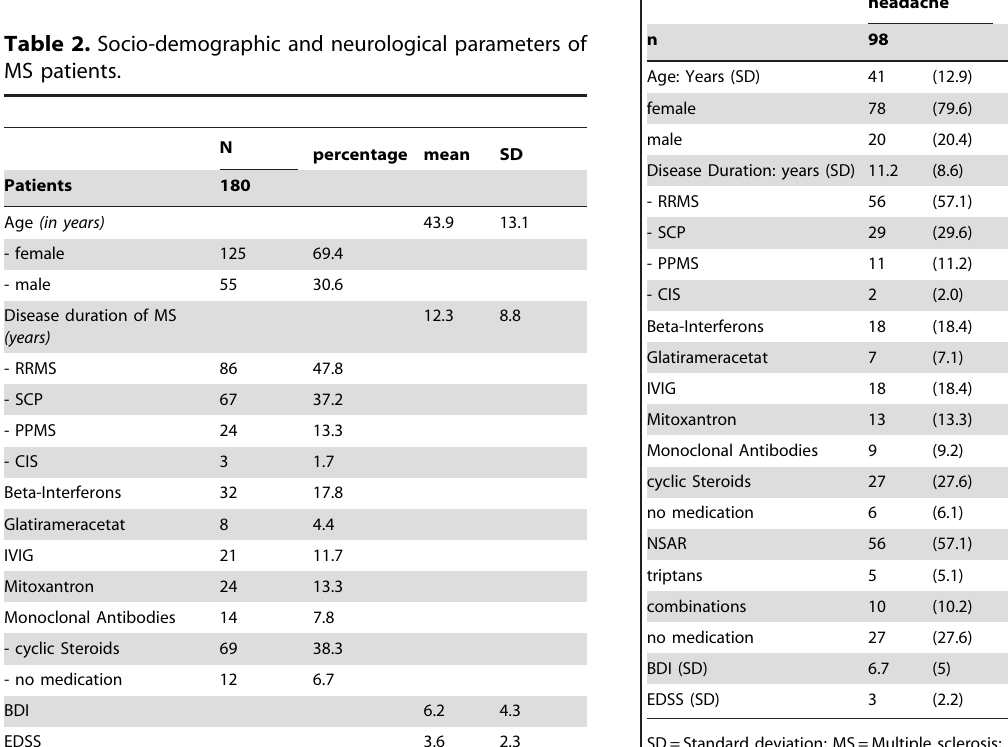
SD=Standard deviation; MS=Multiple sclerosis; EDSS=Expanded Disability State Score; BDI=Beck’s Depression inventory; RRMS=Relapsing/Remitting MS; SCP=Secondary chronic progressive MS; PPMS=Primary chronic progressive MS; CIS=Clinical isolated syndrome. IVIG = intravenous immunoglobulin. NSAR, triptans, combinations, no medication in case of headache treatment. * p , 0.05; **: p , 0.01, ***: p ,